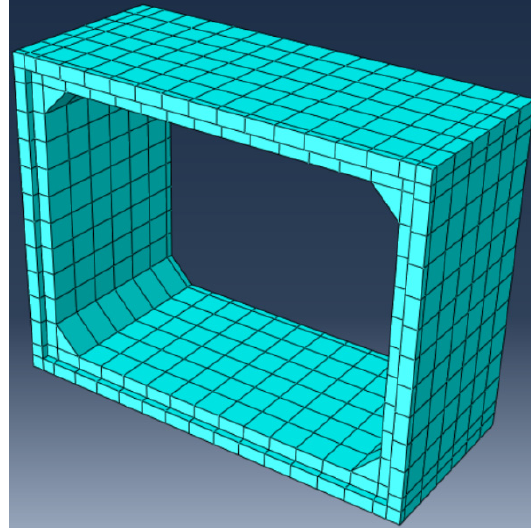
Figure 4. Meshing of the utility tunnel.